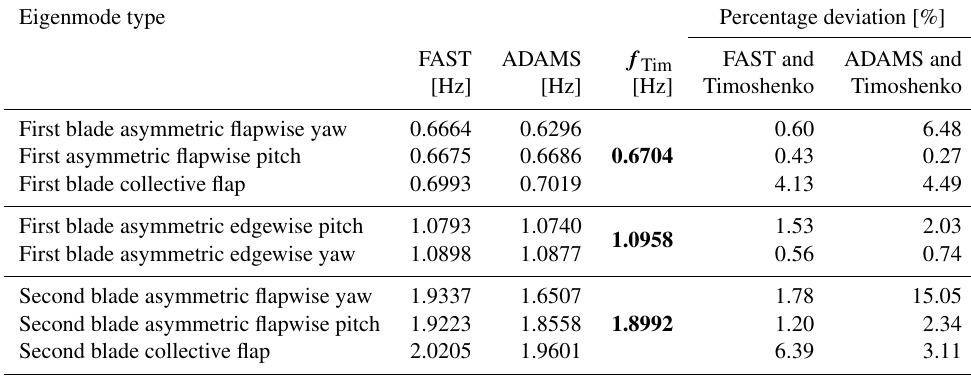
Table 1. First three calculated (bolded values) flapwise and edgewise eigenfrequencies. Eigenmode type Percentage deviation [%] FAST ADAMS f Tim FAST and ADAMS and [Hz] [Hz] Timoshenko First blade asymmetric flapwise yaw First asymmetric flapwise pitch